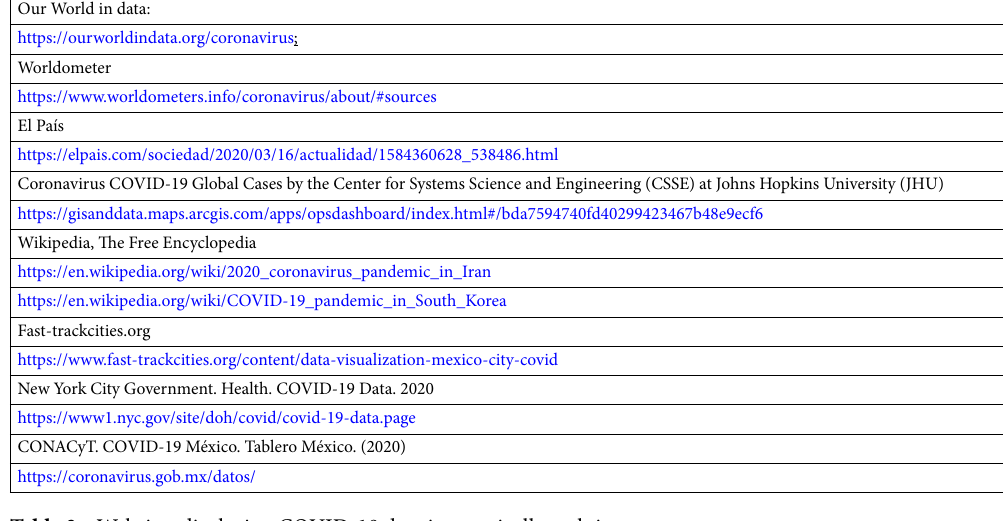
Table 2. Websites displaying COVID-19 data in practically real